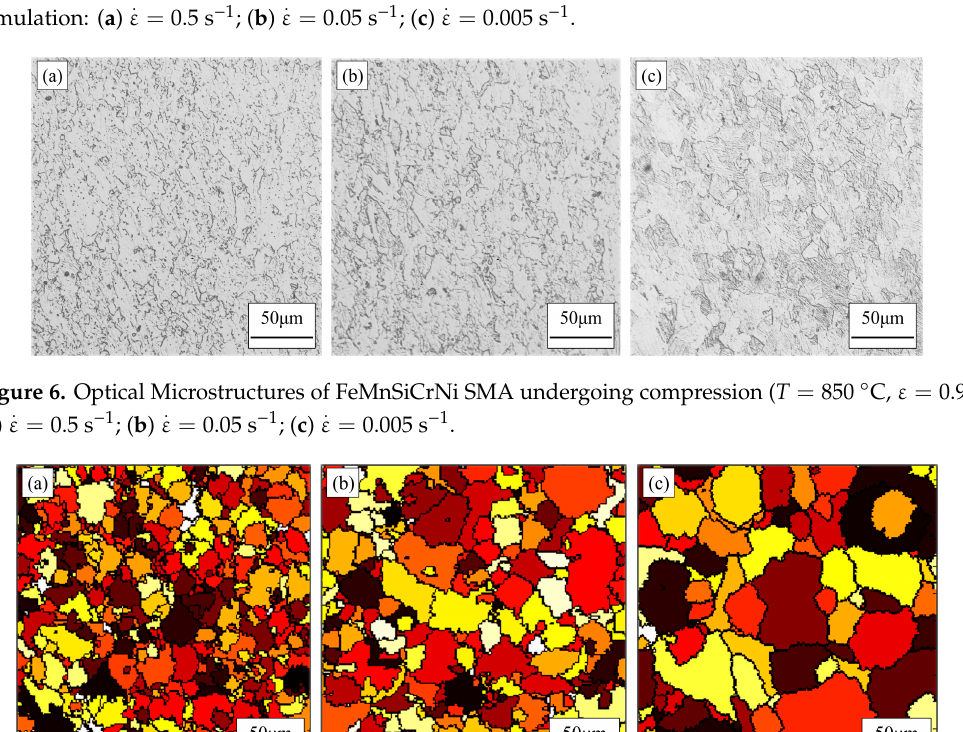
Figure 7. Microstructures of FeMnSiCrNi SMA undergoing compression ( T = 1000 ◦ C, ε = 0.9) based on CA simulation: ( a )